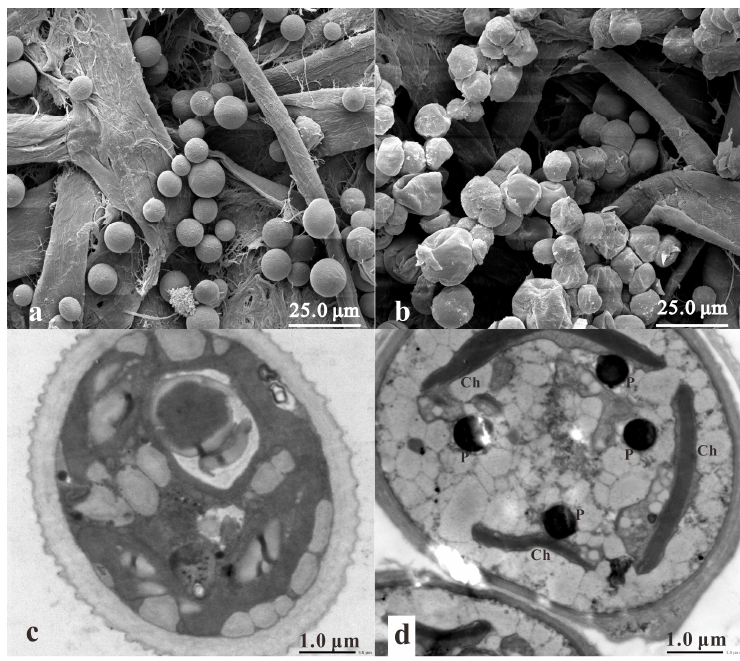
Figure 2. Microscopy and morphological appearance of strain HA-1. Scanning electron micrographs (1000×) of cells in green stage ( a ) and red stage ( b ). Transmission electron micrographs (4000×) of cells in green stage ( c ) and red stage ( d ). Chloroplast (Ch) and Plastoglobule (P) in red cells are